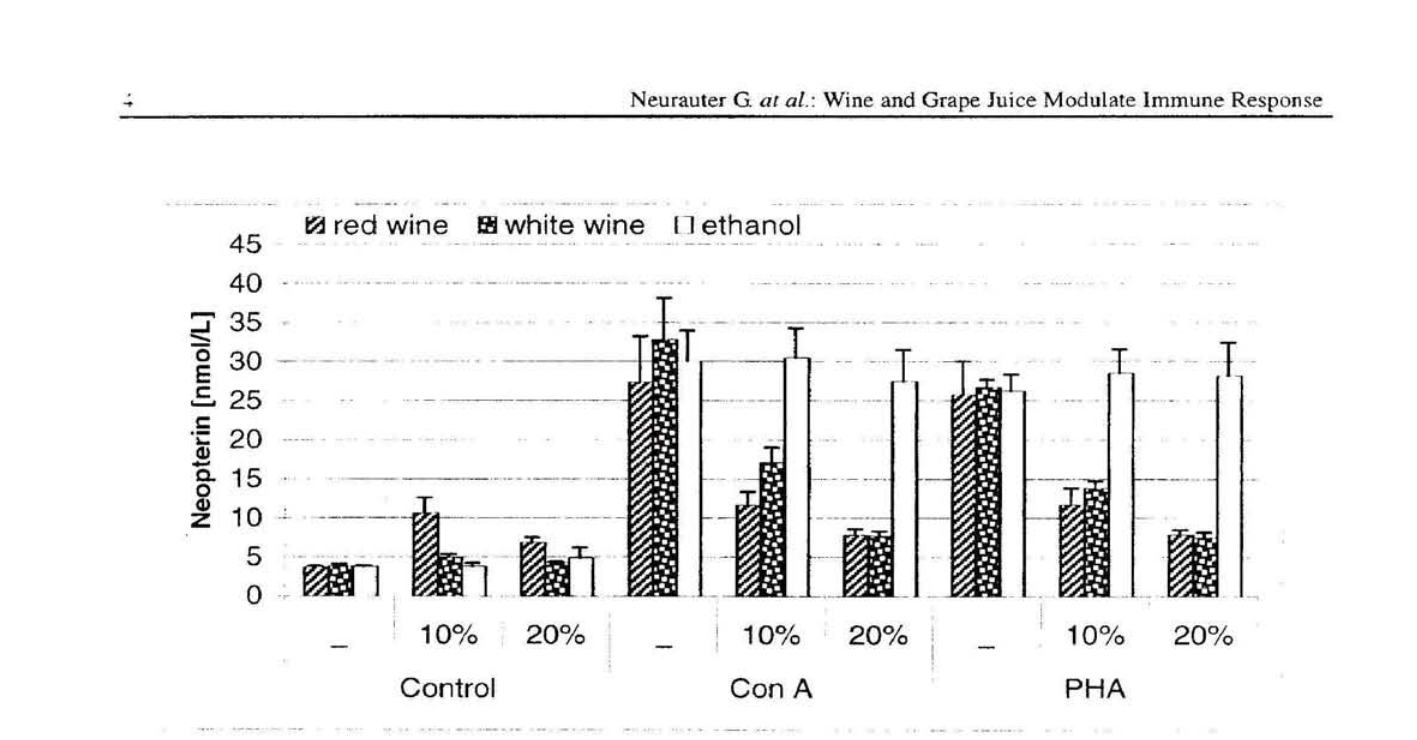
Figure 2. Influence of wines (RW red wine, WW white wine), and ethanol (Eth) on ncoplerin production in pcnpheral blood mononuclear cells induced by mitogens concanavalin A (Con A) and phytohaemagglutinin (PHA); 1:10 (= 10% v/v) and 1:5 (= 20% v/v) dilutions of wine and of 11.5 and 12.0% aqueous ethanol in RPMl (final concentrations 1.2 and 2.3 % ethanol) were tested. (columns show means + S.E.M.; *p<0.05, #p